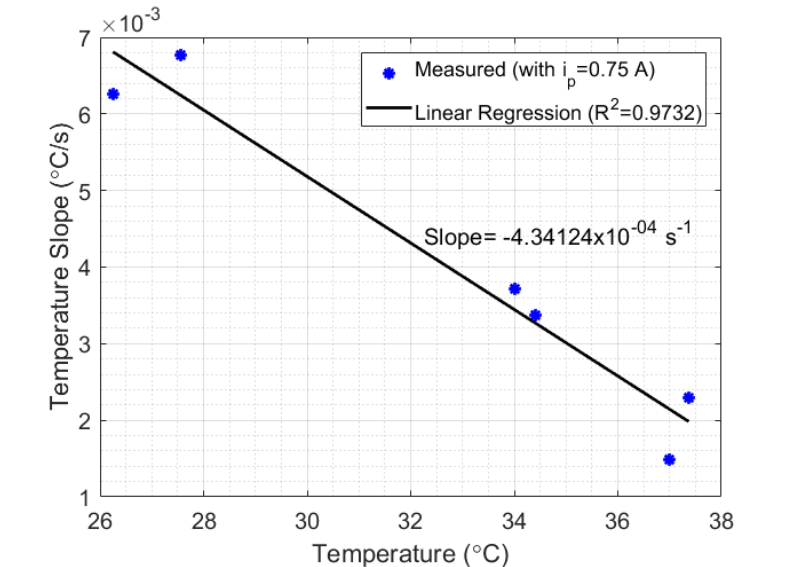
Figure 8. Relationship between the initial temperature and the temperature slope relative to time, calculated for i p = 0.75 Ã (see Figure 7). The linear relationship between such parameters indicates that the setup losses are lineally dependent on the initial liquid temperature.